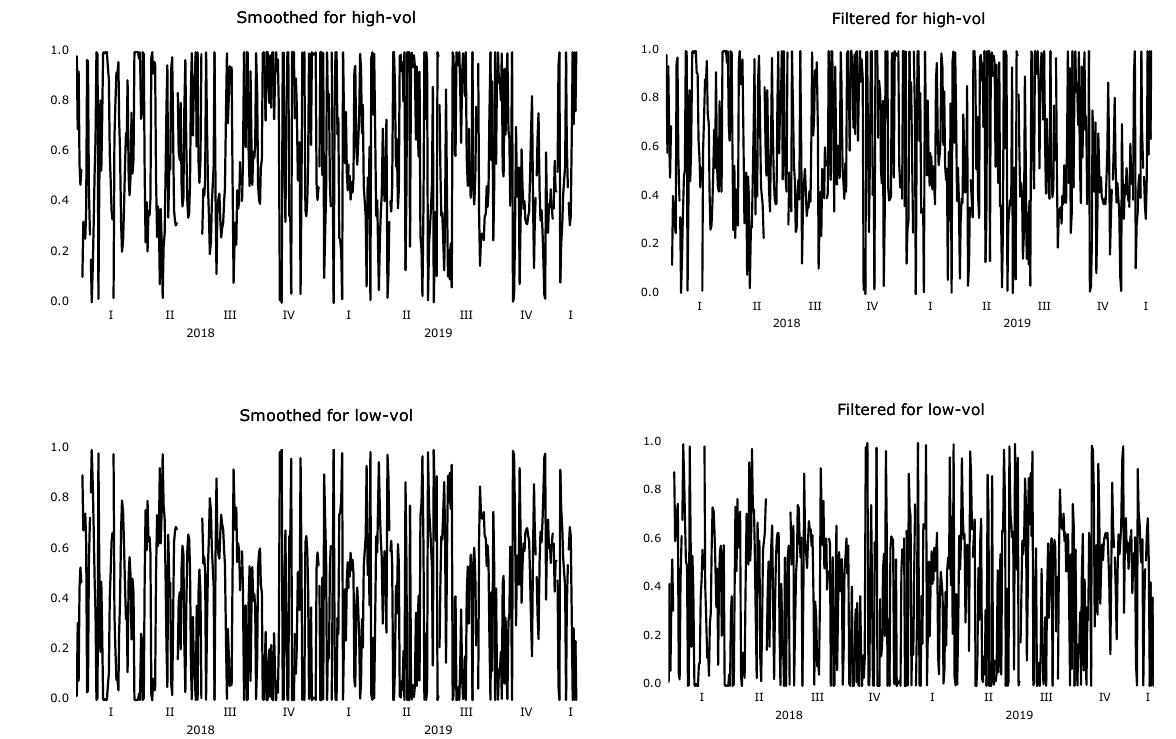
Figure 8. Computed smoothed probabilities and filtered conditional volatilities for SMH.